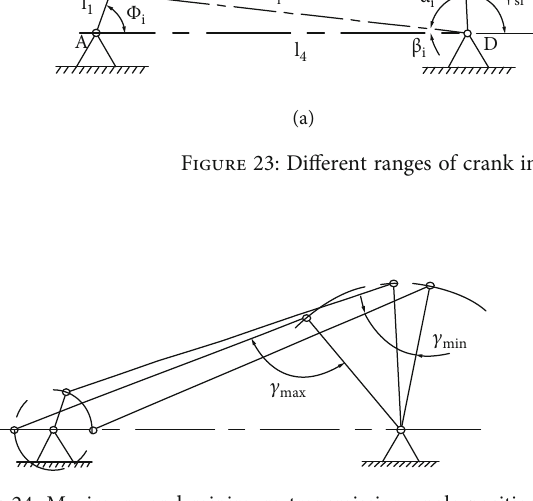
Figure 24: Maximum and minimum transmission angle position of the mechanism.